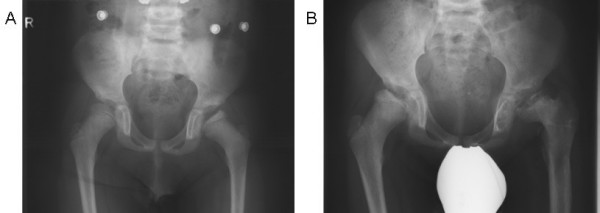
Coxarthrosis in alpha-mannosidosis. A. Coxarthrosis at 8 years of age. B. Progression of coxarthrosis at age 13.